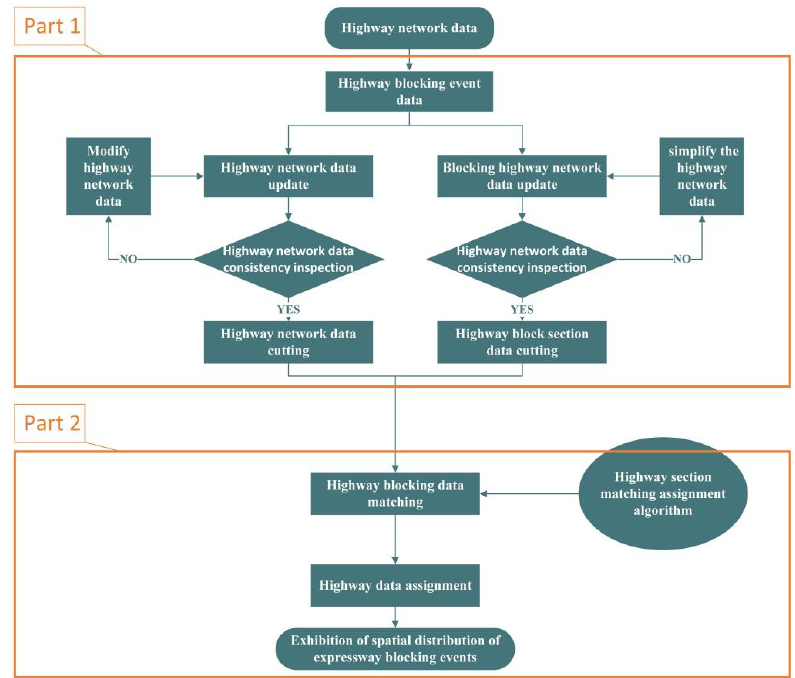
Figure 2. Flow chart of matching assignment of highway block sections.